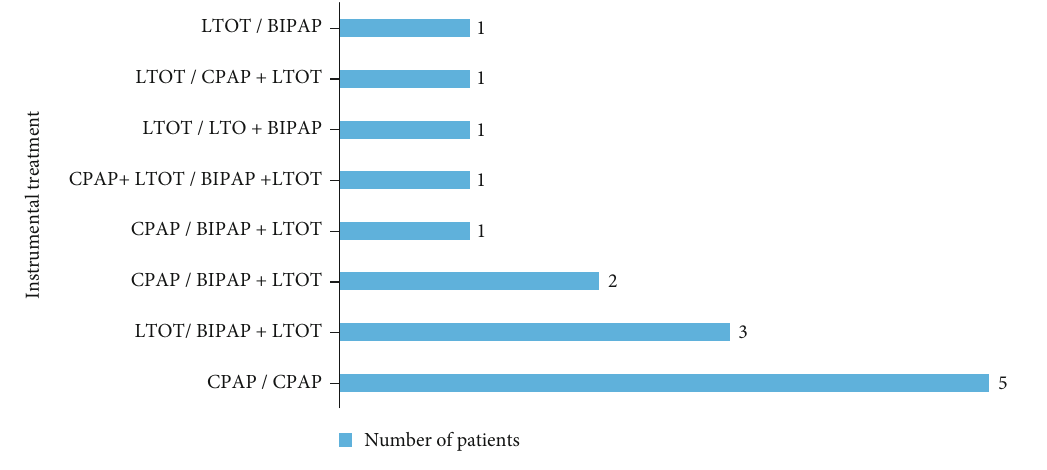
Figure 4: Instrumental respiratory therapy before admission for AHRF and after hospital discharge. LTOT: long-term oxygen therapy; CPAP: continuous positive airway pressure; BiPAP: bi-level positive airway pressure. Table 3: Discharge instrumental respiratory therapy in the overall population, in men, in women, in patients with malignant OHS, and patients with nonmalignant